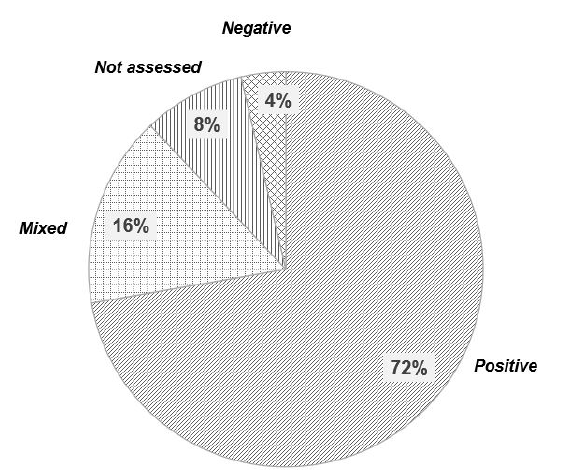
Figure 7. Studies ( n = 272) by relationship assessed between gardening and the measured outcome/s.